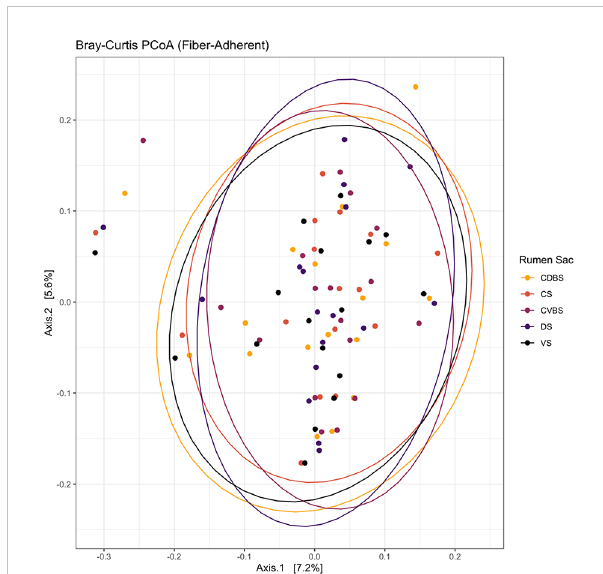
FIGURE 6 Bray-Curtis principal coordinates analysis of the fi ber-adherent fraction among the fi ve rumen sacs. Beta-diversity was measured with the Bray-Curtis distances and visualized with a principal coordinates analysis (PCoA). The CDBS is shown in the orange circles, CS is shown in red circles, CVBS is shown in light purple circles, DS is shown in dark purple circles, and VS is shown in black circles. The circles represent a 95% con fi dence interval around the means of the fi ber- adherent bacterial communities within each rumen sac. No signi fi cant amount of distance was determined (P >